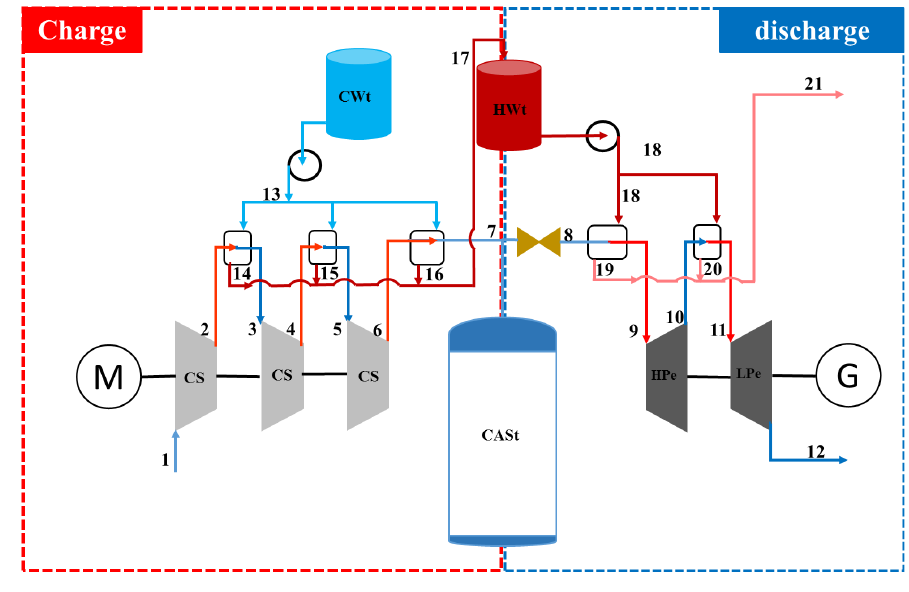
Figure 7. Schematic diagram of optimized system. Table 7. Thermodynamic properties of each point of the optimized